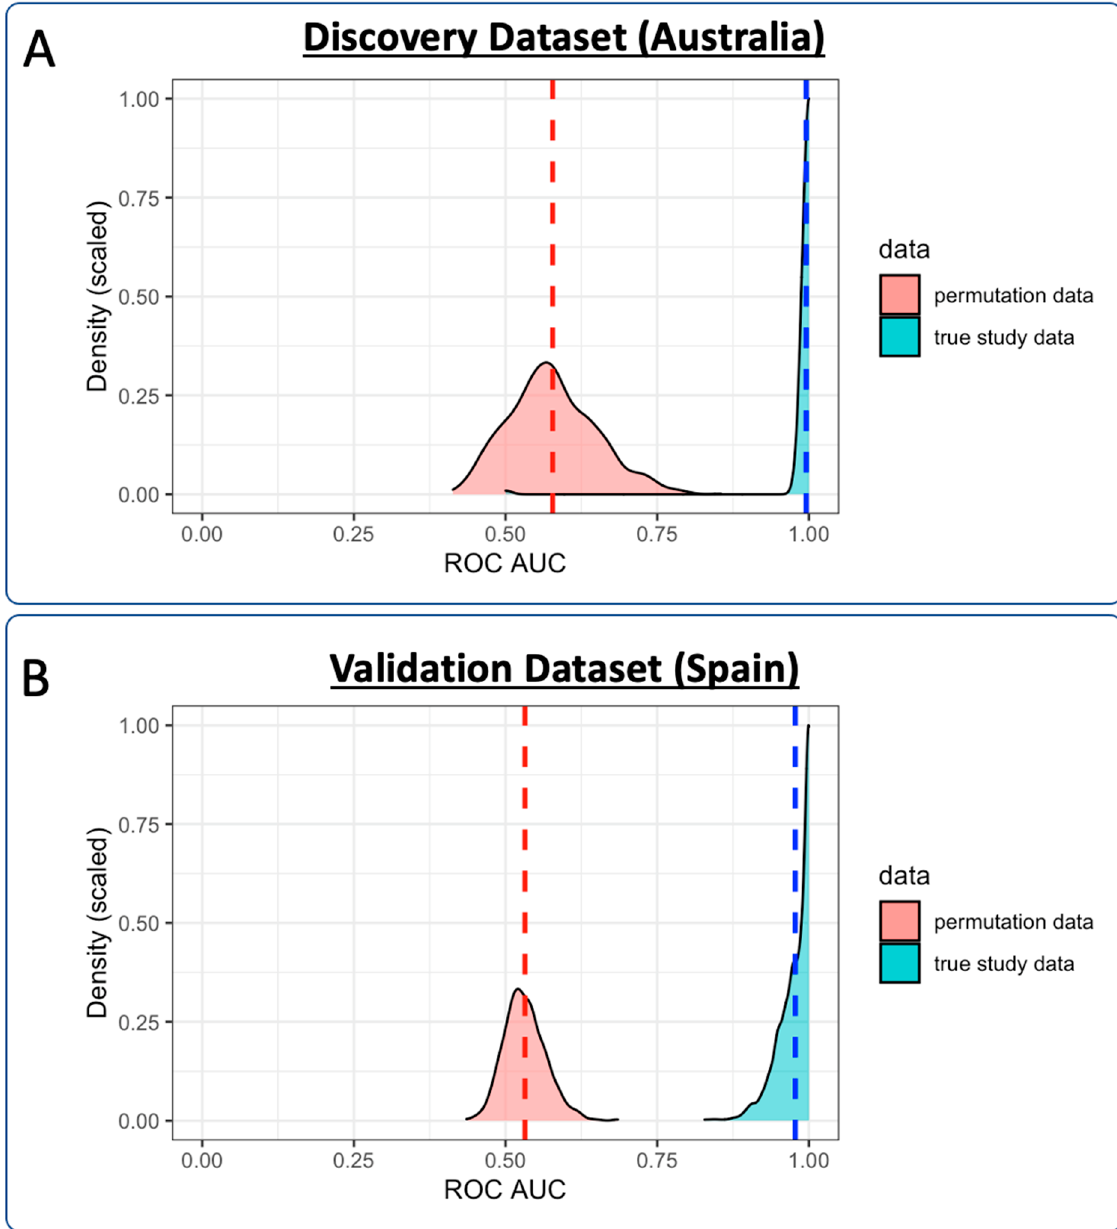
( B ) the validation dataset (Spain) comparing SARS-CoV-2-positive individuals with healthy controls; training set (CV- AUC = 0.977, CV-sensitivity = 0.855, CV-specificity = 0.948); test set (AUC = 0.978, sensitivity = 0.948, specificity = 0.922); ( C ) violin plots displaying the distribution of data acquired for the lipid panel. Both the discovery (training/test) and validation (training/test) cohorts demonstrated similar trends when comparing healthy controls to SARS-CoV-2-positive groups. Results of Mann–Whitney tests between the healthy control and SARS-CoV-2-positive groups for both the discov- ery and validation cohorts are reported in Table 2. The comparison of healthy control, SARS-CoV-2-negative, and SARS- CoV-2-positive groups can be found in Figure S2.